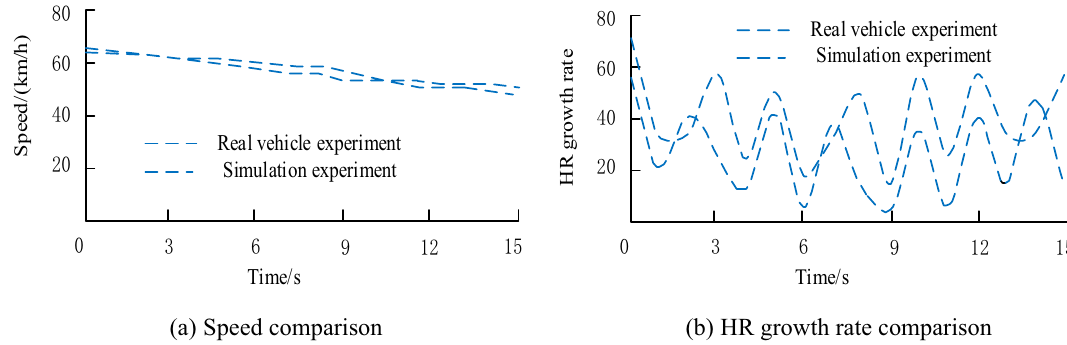
Figure 8. Verification of the effectiveness of the experimental platform.